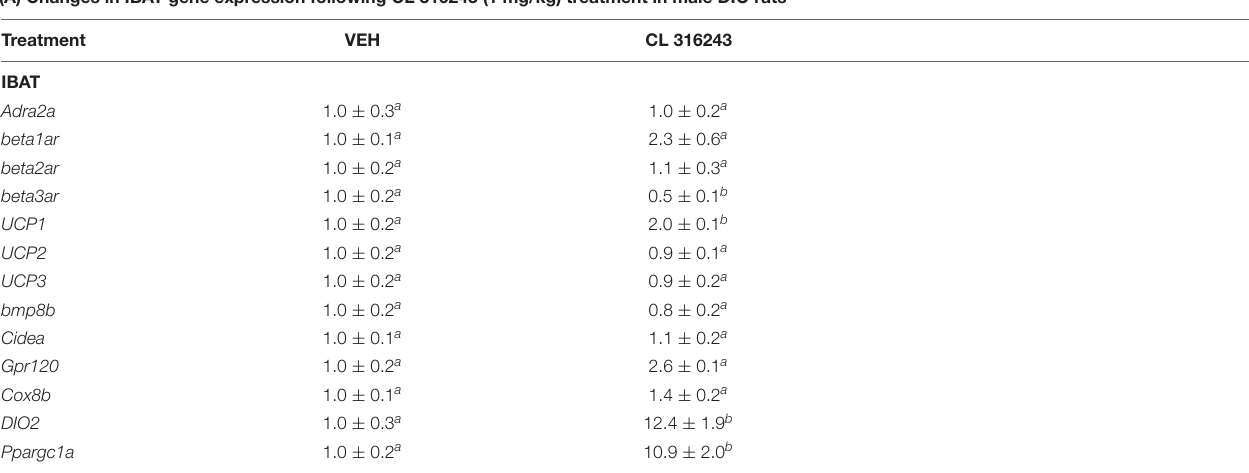
TABLE 1 | Changes in IBAT and IWAT gene expression following CL 316243 treatment in male DIO rats. (A) Changes in IBAT gene expression following CL 316243 (1 mg/kg) treatment in male DIO